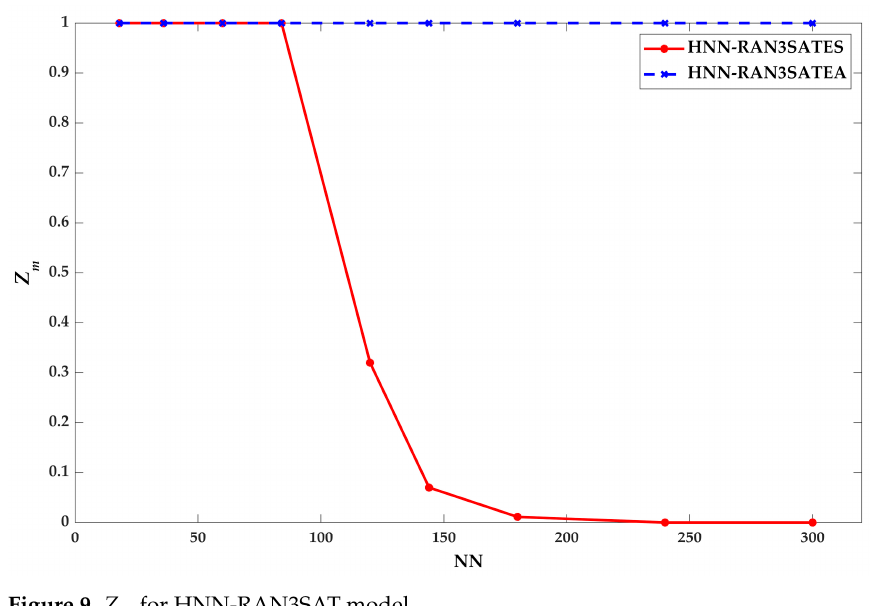
Figure 9. m Z for HNN-RAN3SAT model. Figure 9. Z m for HNN-RAN3SAT model.